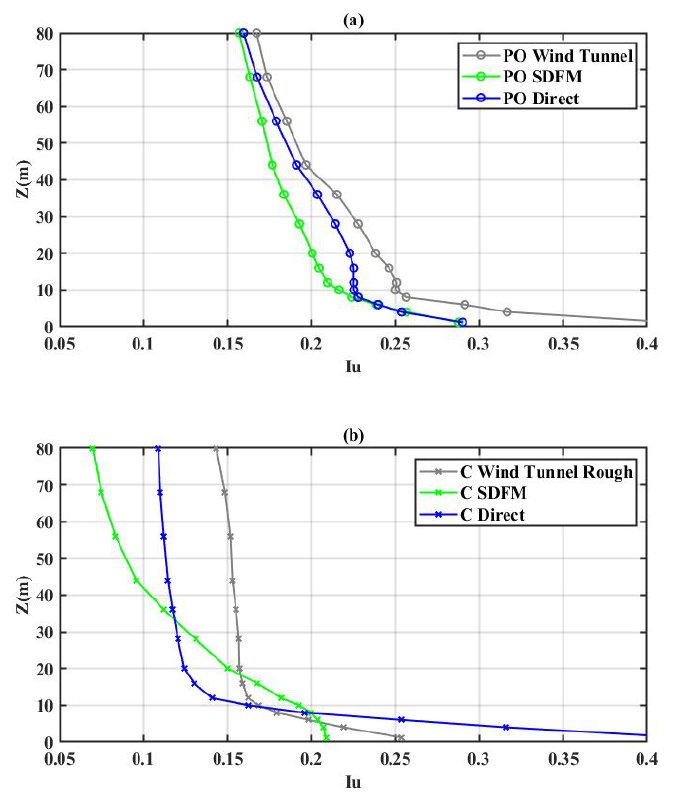
Figure 6. Turbulence intensity at ( a ) PO and ( b ) C as extracted from experiments and calculated by SDFM and direct